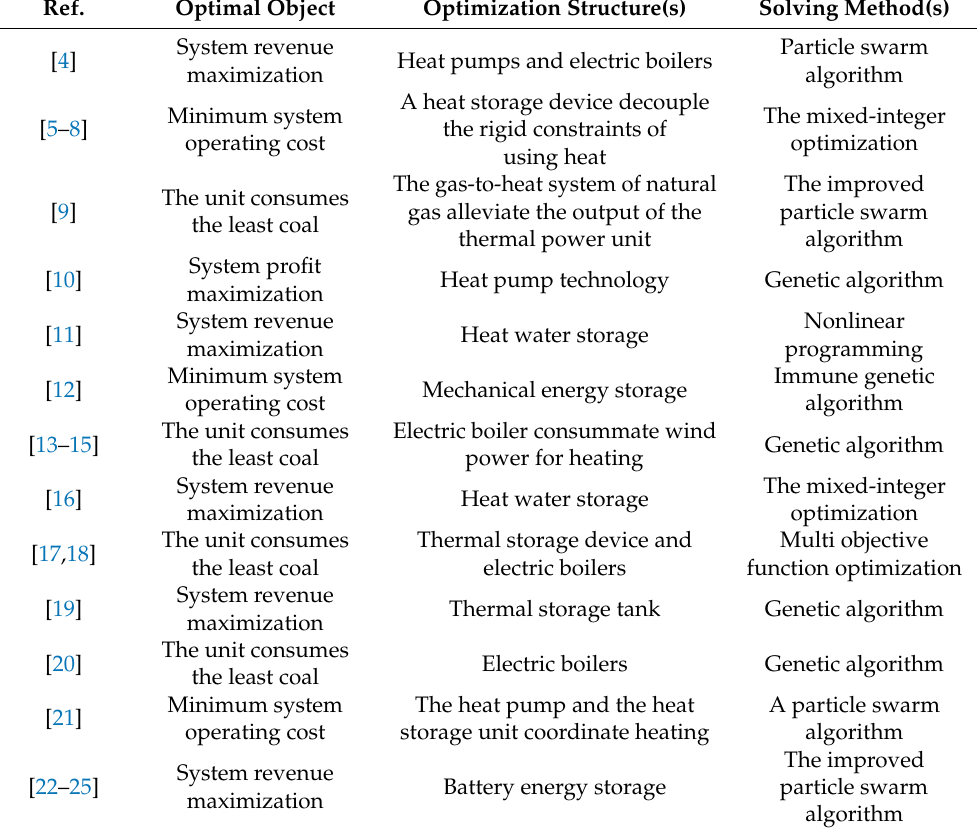
Table 1. The state of the art of the combined heat and power